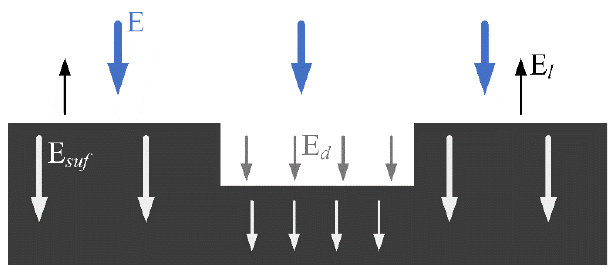
Figure 5. Heat conduction model of carbon ‐ fiber ‐ reinforced composite surface.